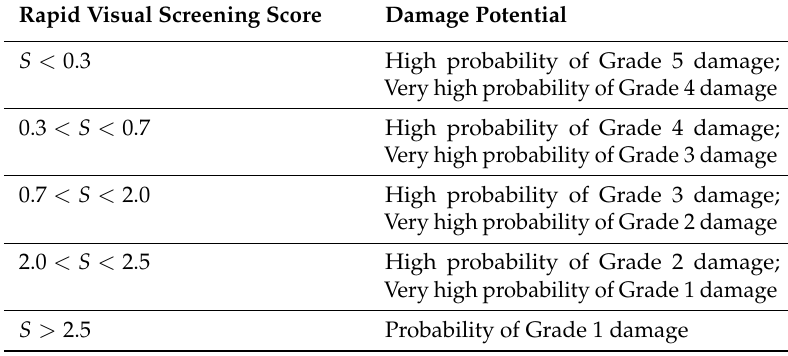
Table 1. Damage state classification and structural scores [34].